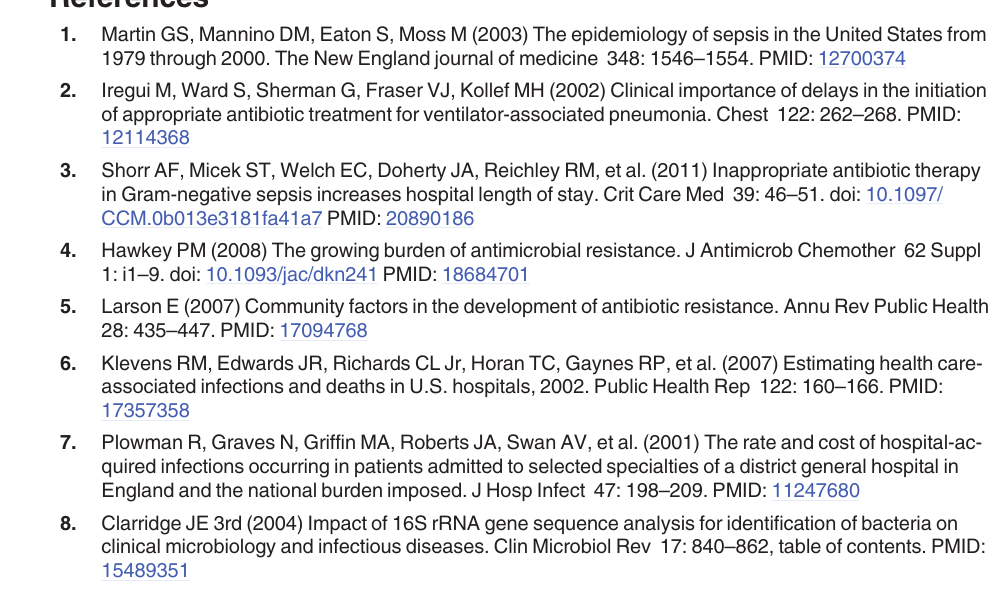
S2 Dataset. Naive Bayes Classifier training set sequences and their taxonomic labels. S3 Dataset. Number of sequences in the training set for genus and species levels. S4 Dataset. 16S based identification for 617 clinical isolates. For each isolate, its original clinical identity is listed together with the 16S rRNA gene sequence and genus/species classifi- cations using Naïve Bayes Classifier and 16SpathDB 2.0. S5 Dataset. Characteristics of within genera percent identity distributions (Fig. 2, gray vio- lin plots). S6 Dataset. Characteristics of within species percent identity distributions (Figs. 3 and 4, gray violin